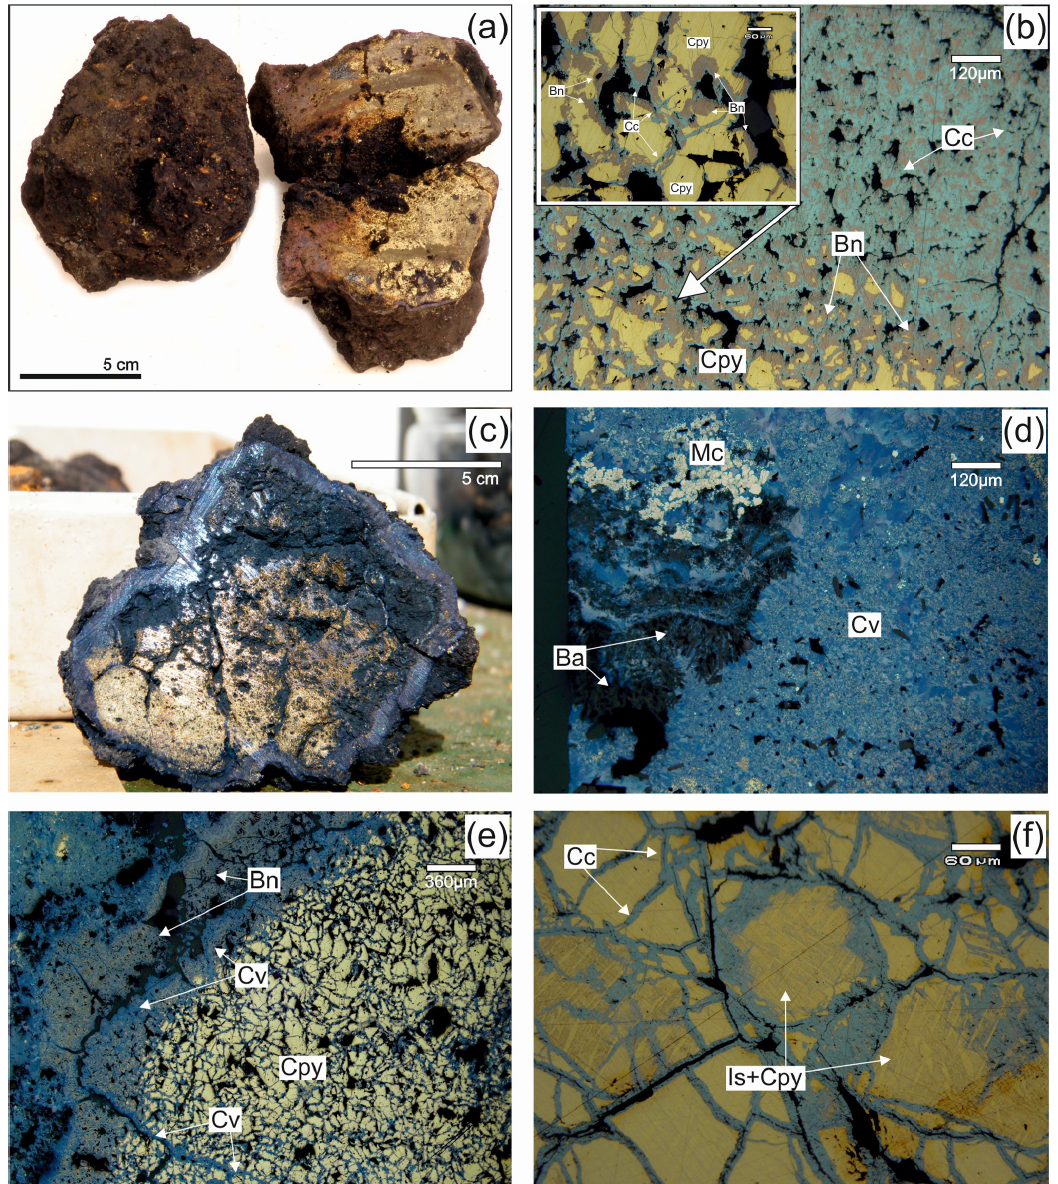
Figure 3. Chalcopyrite chimneys. ( a ) A general view of small chalcopyrite chimneys composed of chalcopyrite, bornite and Cu-sulphide; ( b ) Reflected light photograph. Chalcopyrite (Cpy) is partly replaced by bornite (Bn) and by minerals of the chalcocite (Cc) series (277-T-6); ( c ) A general view of large chalcopyrite chimney fragment composed of chalcopyrite in the central part and by low Cu-sulphide in the outer zone; ( d ) Reflected light photograph. The outer zone with Cu-sulphides of the covellite series, along with Barite (Ba) and marcasite (Mc) (277- Т- 3); ( e ) Reflected light photograph. Layered structure of a chimney with chalcopyrite (Cpy), covellite (Cv) and bornite (Bn) zones (277- Т- 3); ( f ) Reflected light photograph. Small chimney composed of isocubanite-chalcopyrite lattice aggregates, which are replaced by minerals of the chalcocite series (293- Т-